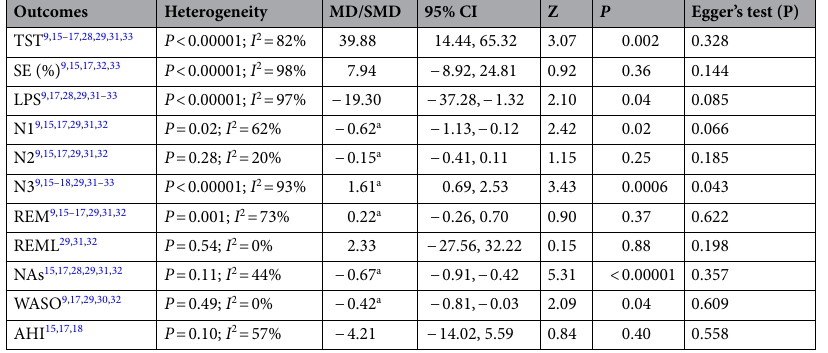
Table 2. Summary of pooled effects of trazodone on PSG parameters for insomnia disorder (MDs or SMDs based on differences in values at follow-up). AHI apnea–hypopnea index, CI confidence interval, LPS